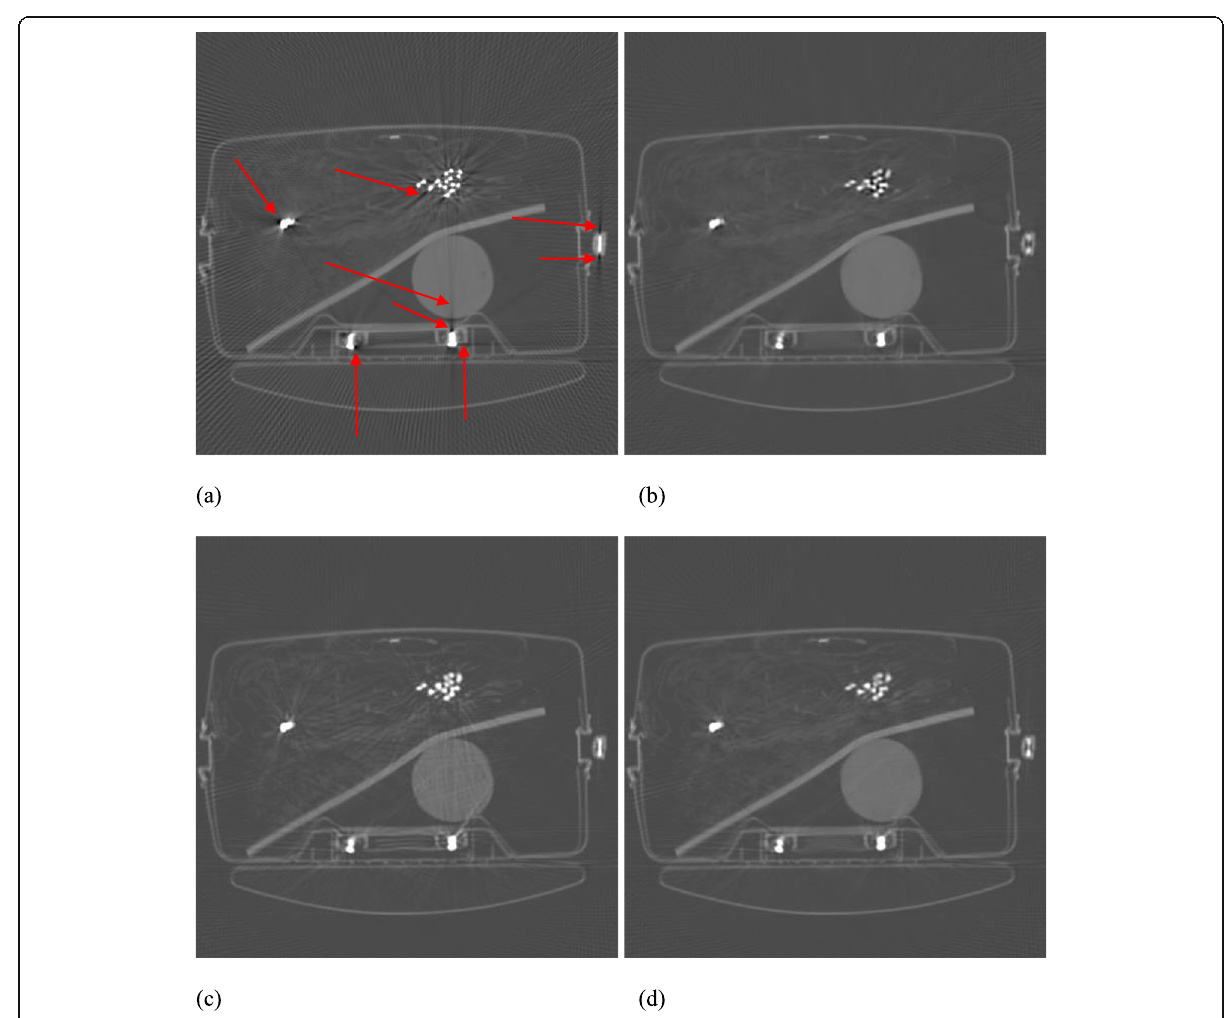
Fig. 1 Reconstruction of bag #1. a Raw FBP; b TV-term only; c Non-negativity-term only; d Combined. Some artifacts are marked by the red